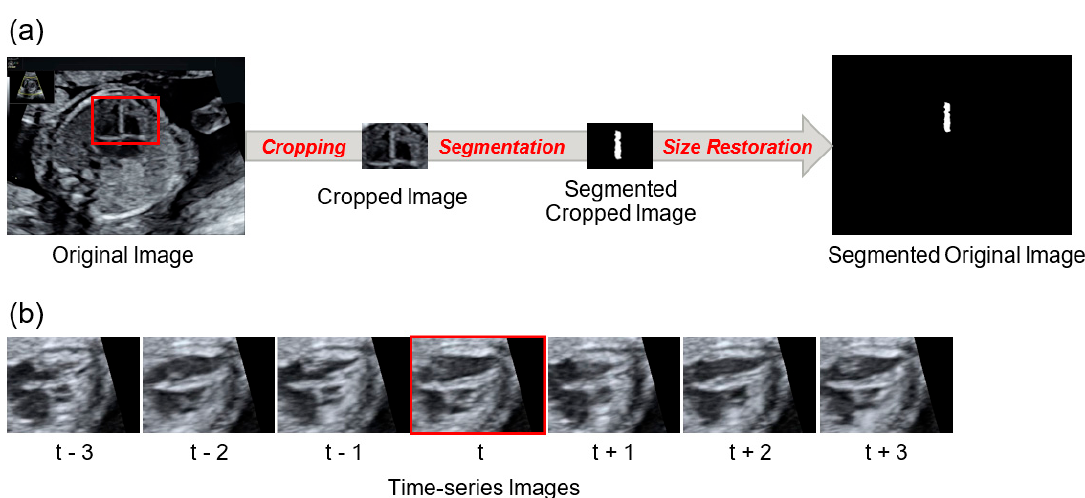
Figure 1. Cropped image and time-series image. ( a ) The “original image” is cropped and transforms into the “cropped image”; the cropped image is segmented and transforms into the “segmented cropped image”. The segmented cropped image is then restored to its original size and transforms into the “segmented original image”. ( b ) A segmentation target image is labelled “t”, and pre- / post- time-series images are labelled “t ± 1, 2, 3”. All of them were cropped.